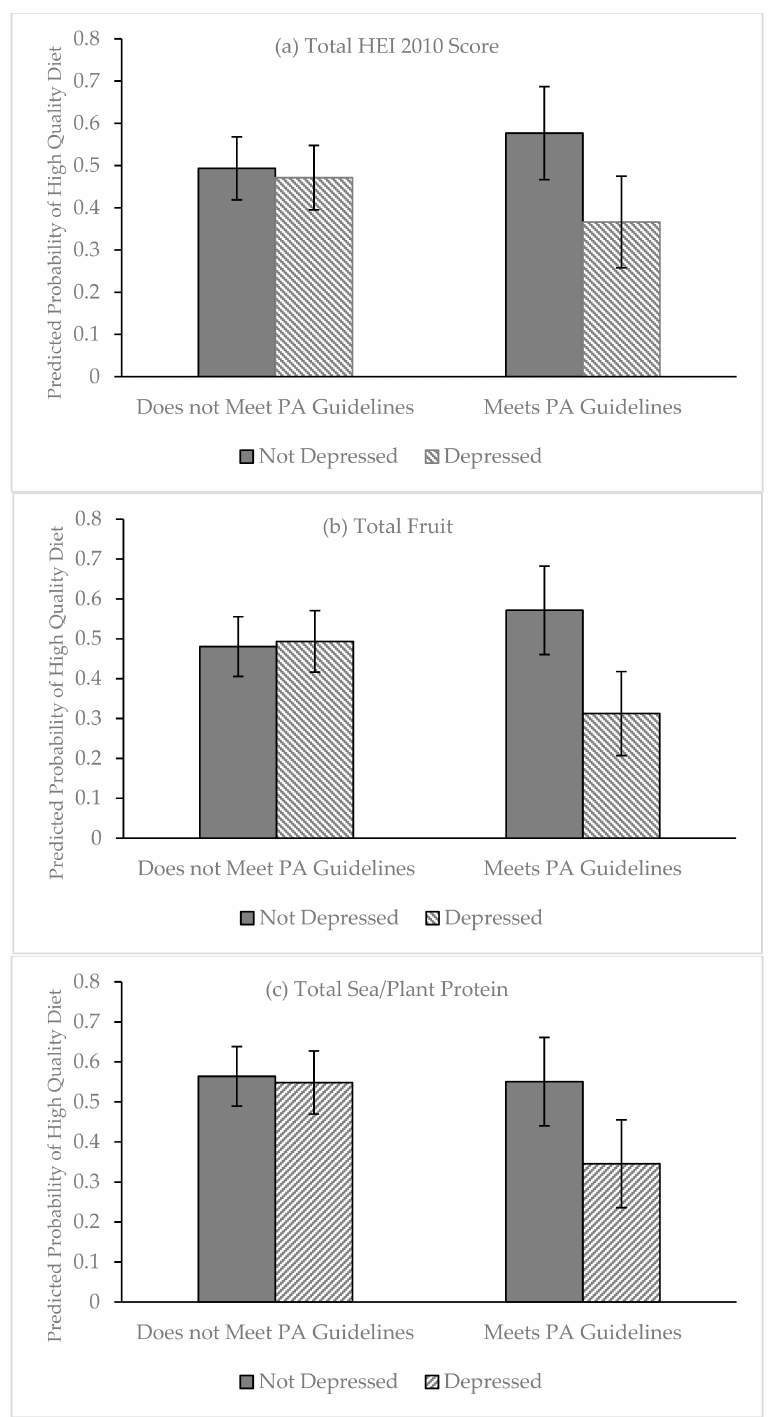
Figure 1. Predicted probabilities of high-quality diet across depressive symptoms and physical activity guidelines; Enlace (2012–2016; n = 462). Depressed Latinas, compared to non-depressed Latinas, showed significantly lower probabilities of having high-quality total HEI 2010 scores ( p = 0.019), total fruit ( p = 0.013), and total sea / plant protein ( p = 0.029) when they met physical activity guidelines than when they did